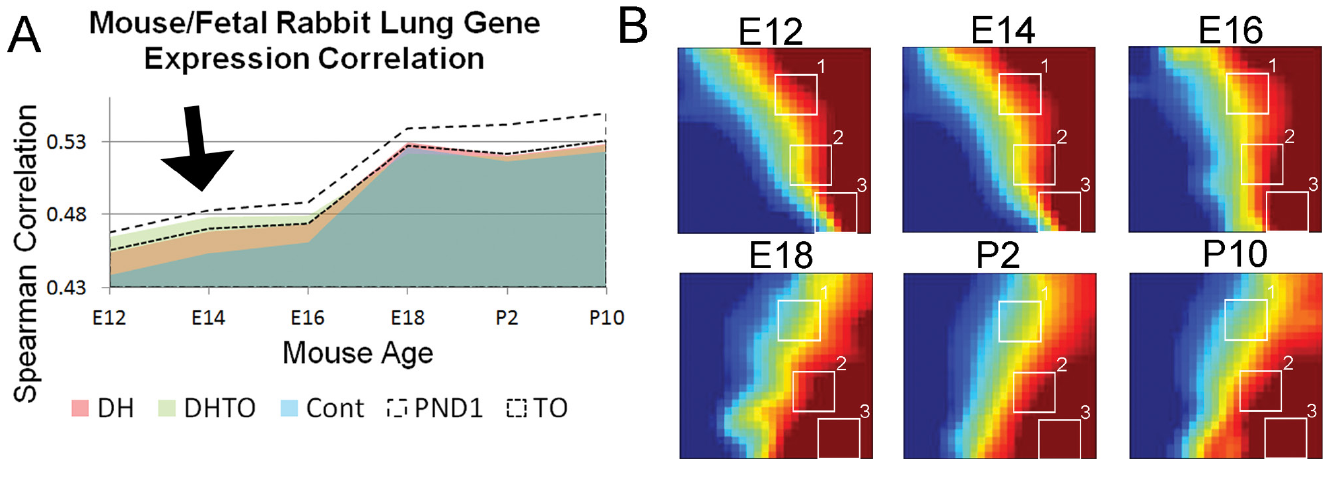
Figure 5. TO does not reverse the immature lung gene expression profile induced by DH. (A) Rabbit lung gene expression was correlated to that of published mouse lung development data (24). While there was a high degree of correlation at E18 and beyond, DHTO and DH lung were more highly correlated at E12, E14 and E16 than control lung. The colors used in this panel are translucent with olive indi- cating DH, TO and DHTO and orange DH and DHTO. (B) The average gene expression profile of each mouse lung age was plotted on the same matrix as the previous fetal rabbit lung matrix. Over the course of lung development, gene expression in region 1 decreases and gene expression in region 3 increases. Gene expression in region 2 is overall unchanged although the pattern